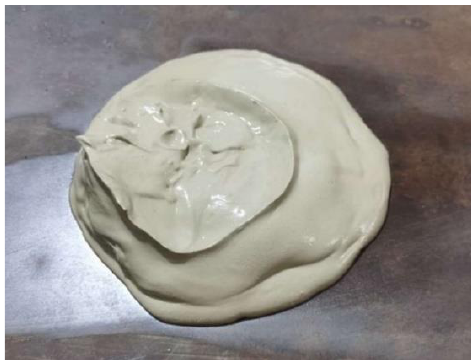
Figure 11. Paste backfilling slurry state.